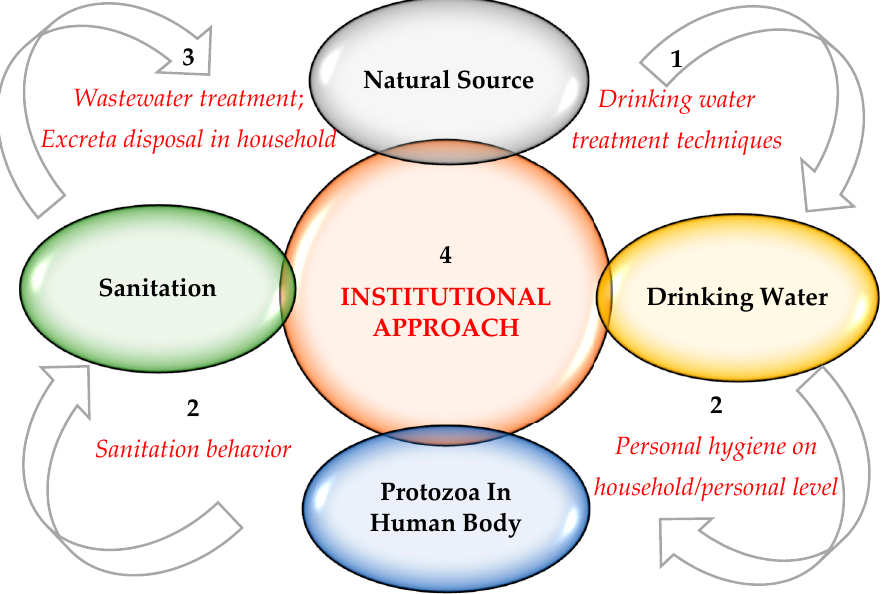
Figure 3. Schematic of systems approach to ensure improved water, sanitation and hygiene (WASH).